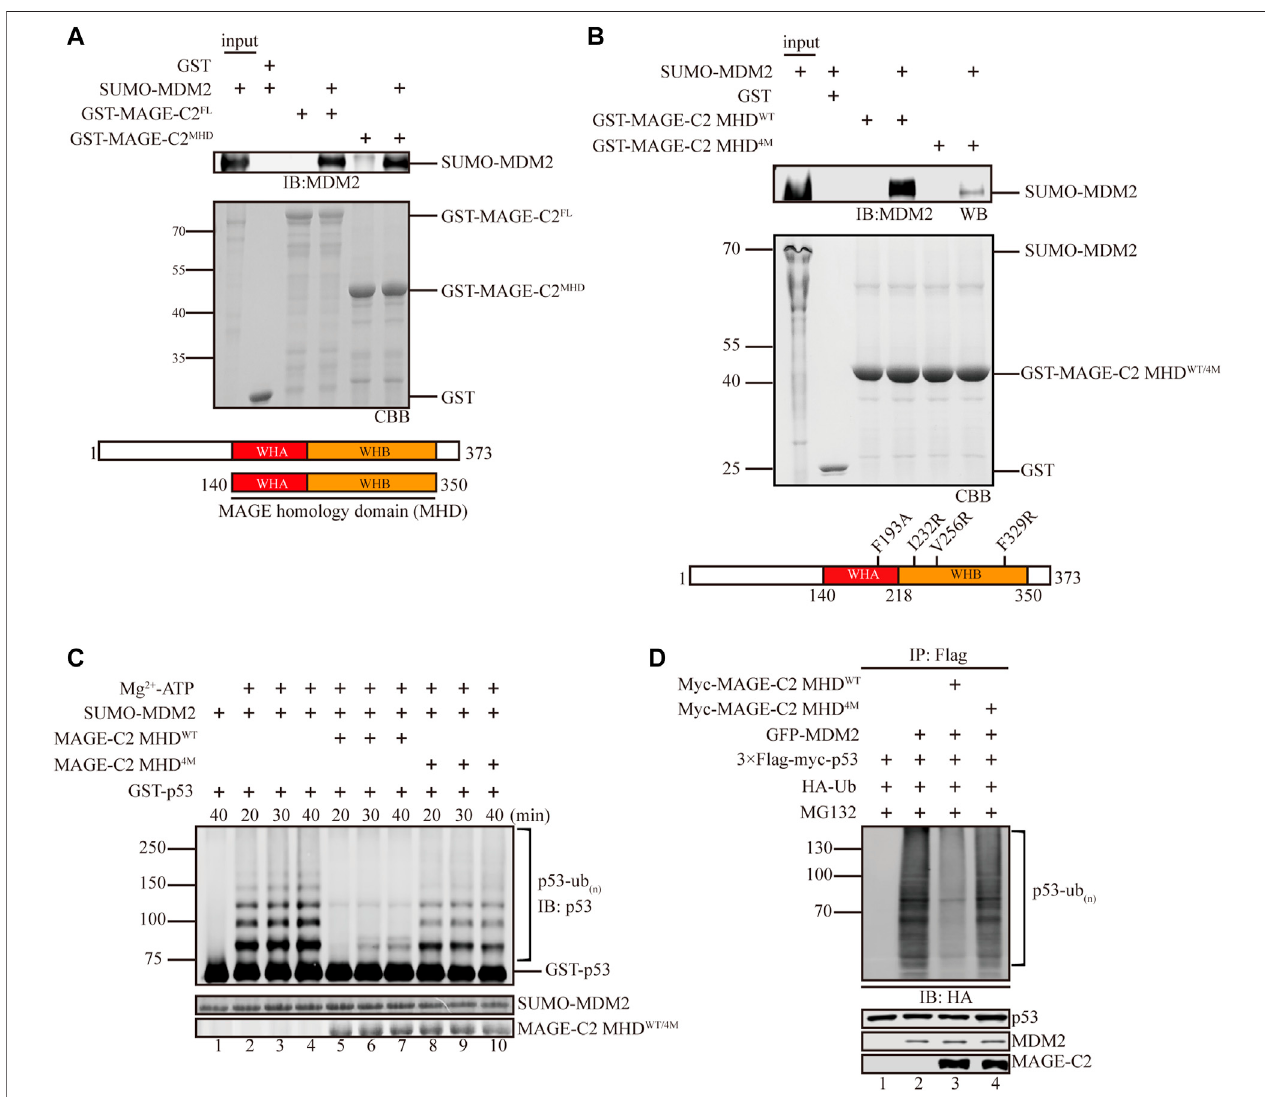
FIGURE 2 | MAGE-C2 directly interacts with MDM2 and inhibits its ligase activity through the MHD domain. (A) Interactions between MAGE-C2 and MDM2 were validated by using GST pulldown assay. The indicated GST- and SUMO-tagged proteins were expressed in bacterium, and SUMO – MDM2 proteins were detected by using anti-MDM2 Western blot. GST was included as an irrelevant negative control protein. (B) Interactions between MAGE-C2 mutants and MDM2 were validated by using GSTpulldown assay. The indicated GST-tagged MAGE-C2 proteins were incubated with in vitro translated SUMO – MDM2.Proteinswere detected byusing anti-MDM2 immunoblotting. (C) In vitro ubiquitination assay. His-ubiquitin, ubiquitin E1, UbcH5B E2, Mg-ATP, GST-p53, and the indicated MAGE-C2 and MDM2 proteins were incubated for speci fi c time at 37 ° C and detected by using anti-p53 immunoblotting. (D) Ubiquitination assay in cells. HEK293T cells were transfected with HA-ubiquitin and indicated plasmids. The level of p53 ubiquitination was determined by using anti-Flag M2-agarose redbeads puri fi cation and anti-HA Western blot.